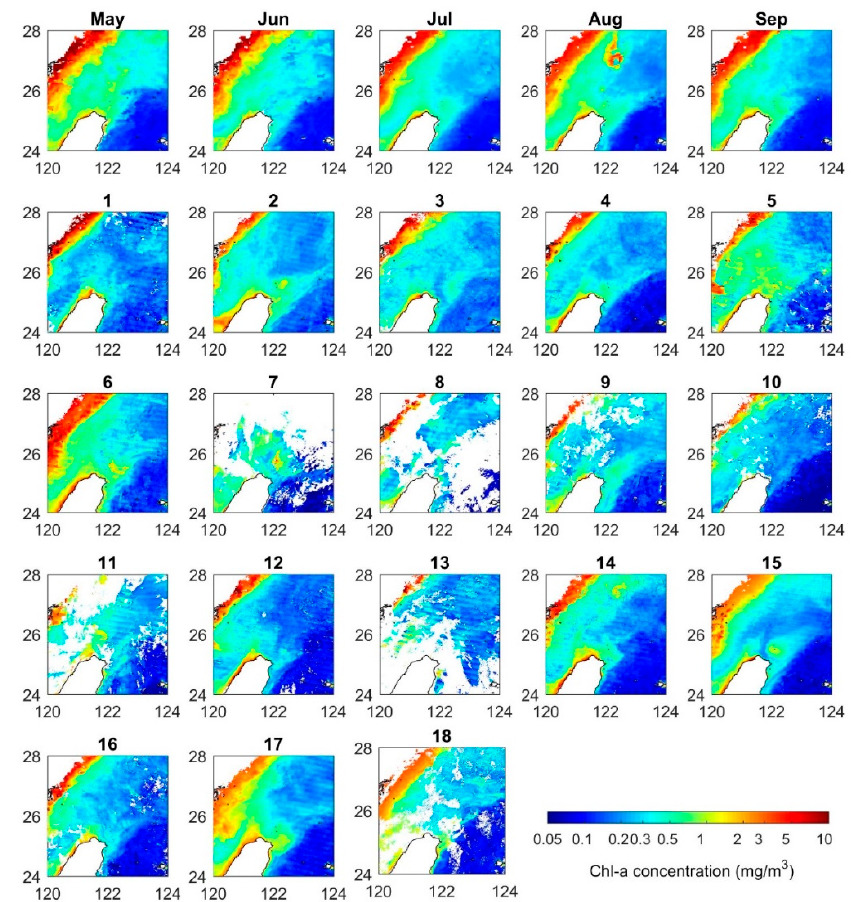
Figure 6. Climatological mean (2009–2013) of monthly Chl-a concentration (mg / m 3 , May–Sep) and the prestorm Chl-a concentration (mg / m 3 , one-week composite images) for the 18 typhoons shown in Figure 2.